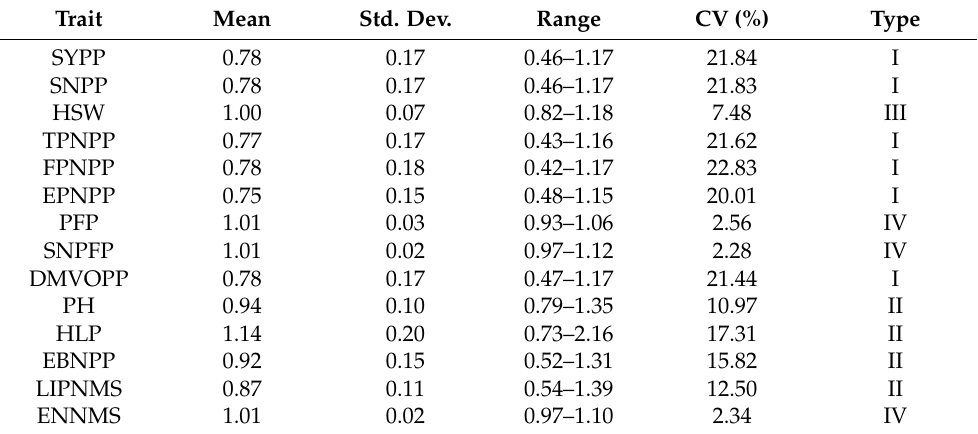
Table 4. Descriptive statistics for ARTC s (acid rain tolerance coefficients) of the 14 traits potentially related to AR tolerance for the tested soybean